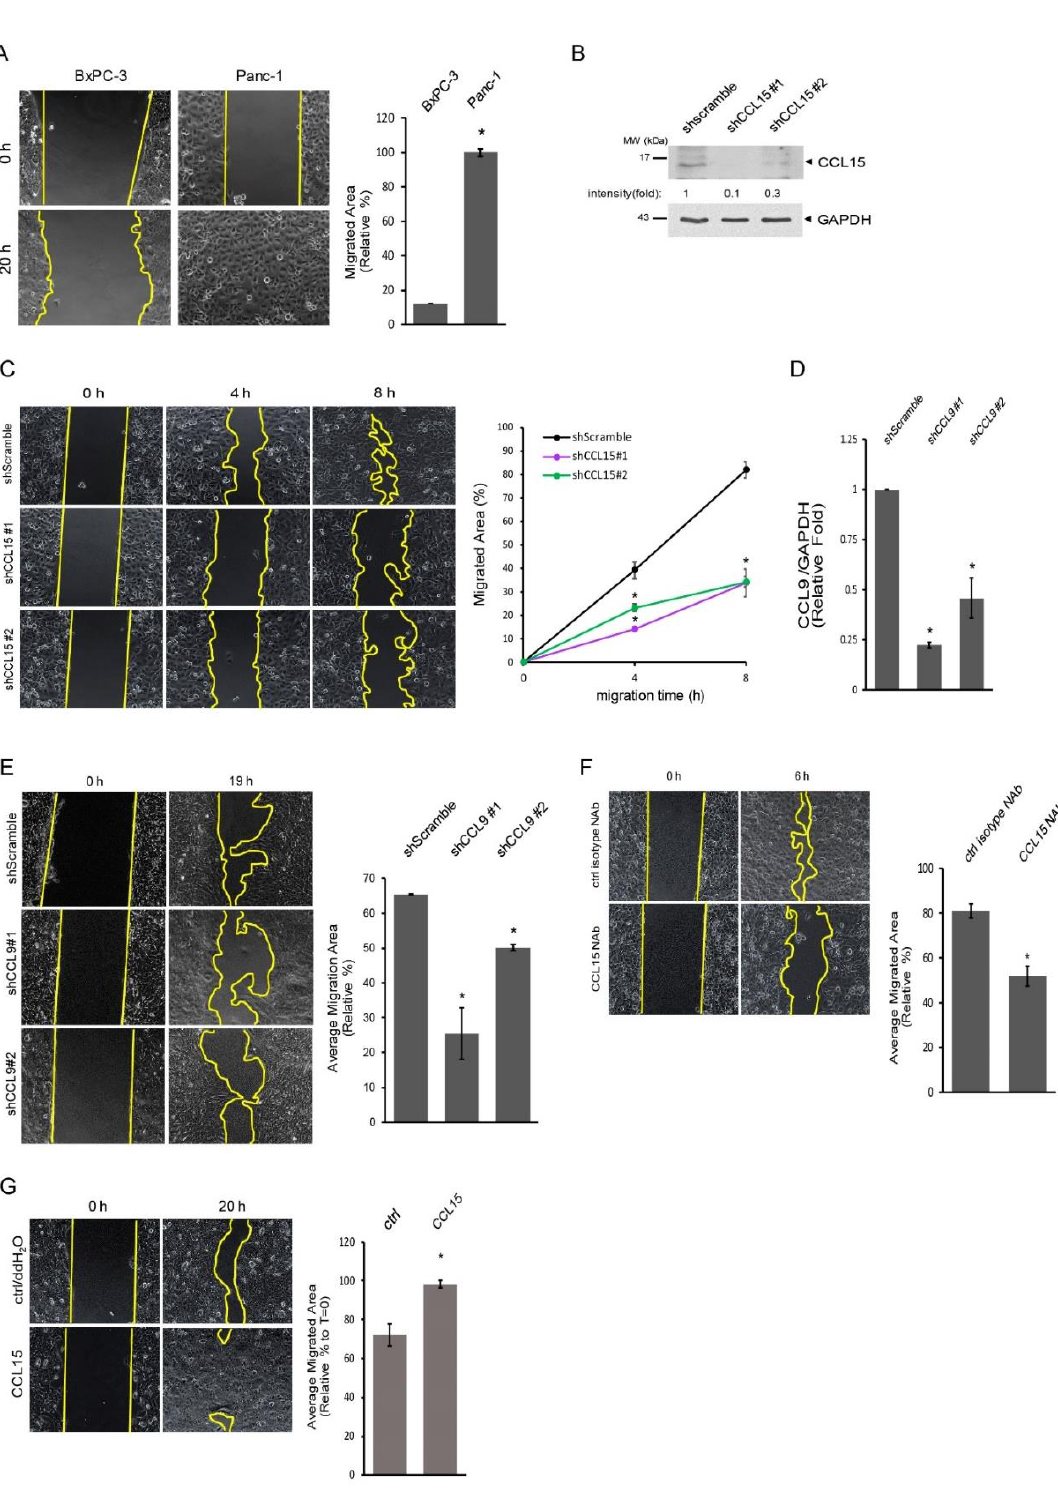
Figure 3. CCL15 mediated PDAC cell migration. ( A ) BxPC-3 and Panc-1 cells were seeded in culture-inserts as described in Section 2. After removal of culture-inserts, cells migrated into the existing gap areas (yellow lines indicate the cell migration front lines) and monitored for 20 h, *: p < 0.05. ( B ) Levels of CCL15 in Panc-1 cells stably expressing shScramble, shCCL15 #1, or shCCL15 #2 were assessed by immunoblots. GAPDH levels were used as a control to assess knockdown efficiency. Quantification result from 4 independent experiments is shown in Figure S3. ( C ) Similar to A, Panc-1 cells stably expressing shScramble, shCCL15 #1, or shCCL15 #2 were assessed for their cell migration abilities at the indicated time points. *: p < 0.05 as compared to shScramble at same time point. ( D ) Levels of CCL9, an orthologue of human CCL15, in murine PDAC KP2 cells stably expressing shScramble, shCCL9 #1, or shCCL9 #2 were examined by real-time qRT-PCR. *: p < 0.05